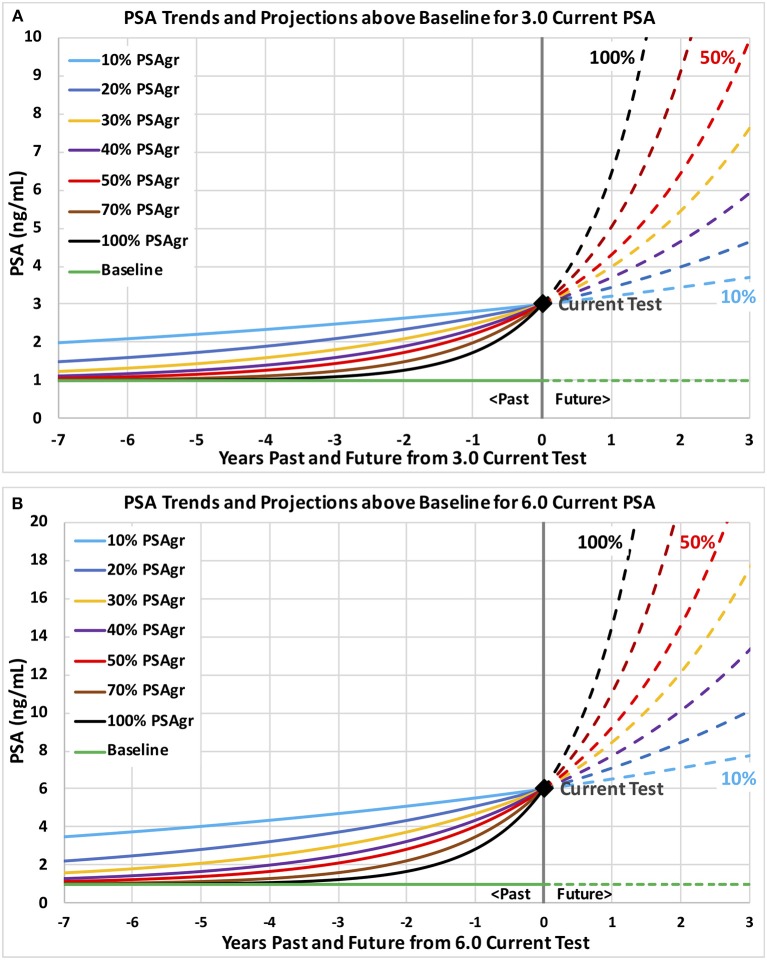
Example PSA trends above a no-cancer baseline through current PSA tests of 3.0 and 6.0 with a range of growth rates. Example PSA trends are plotted and projected with levels on the vertical axis and years past and future on the horizontal axis. Trends are shown on graph (A) through a current PSA test 3.0 and on graph (B) through 6.0. Growth rates in estimated PSA from cancer (PSAgr) range from slow (10%) shown in light blue to very fast (100%) shown in black.